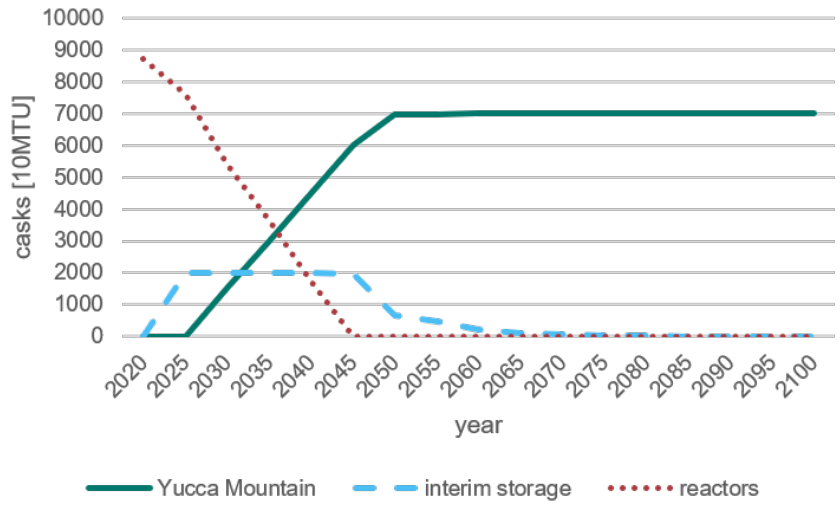
Figure 9. Storage levels in the Yuc_reproc scenario. Source: own representation.